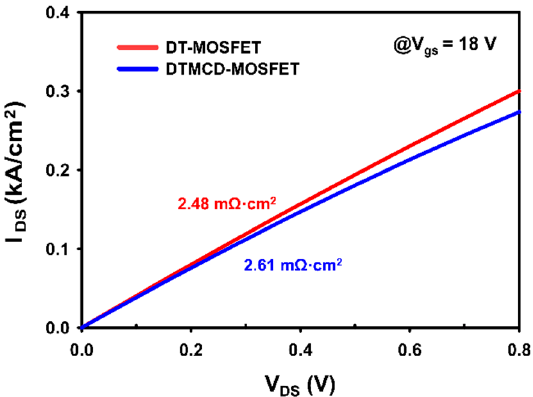
Figure 4. Comparison of the on-state characteristics of DT-MOSFET and proposed DTMCD- MOSFET.